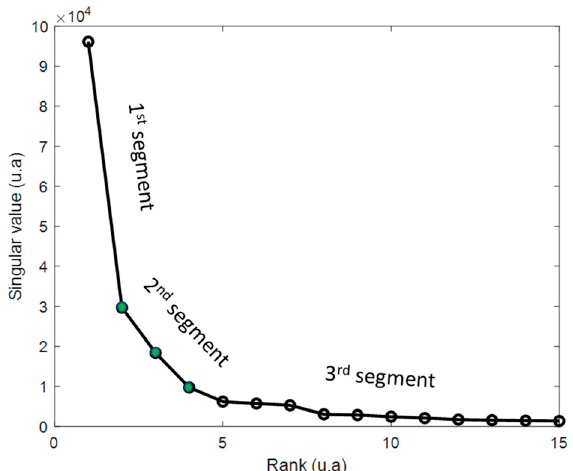
Figure 6. Singular values reported according to their rank, which shows three segments. Three thresholds (green dots) were considered in the second segment and, thus, three reconstructions of the different truncated matrices (different ranks r) were performed.